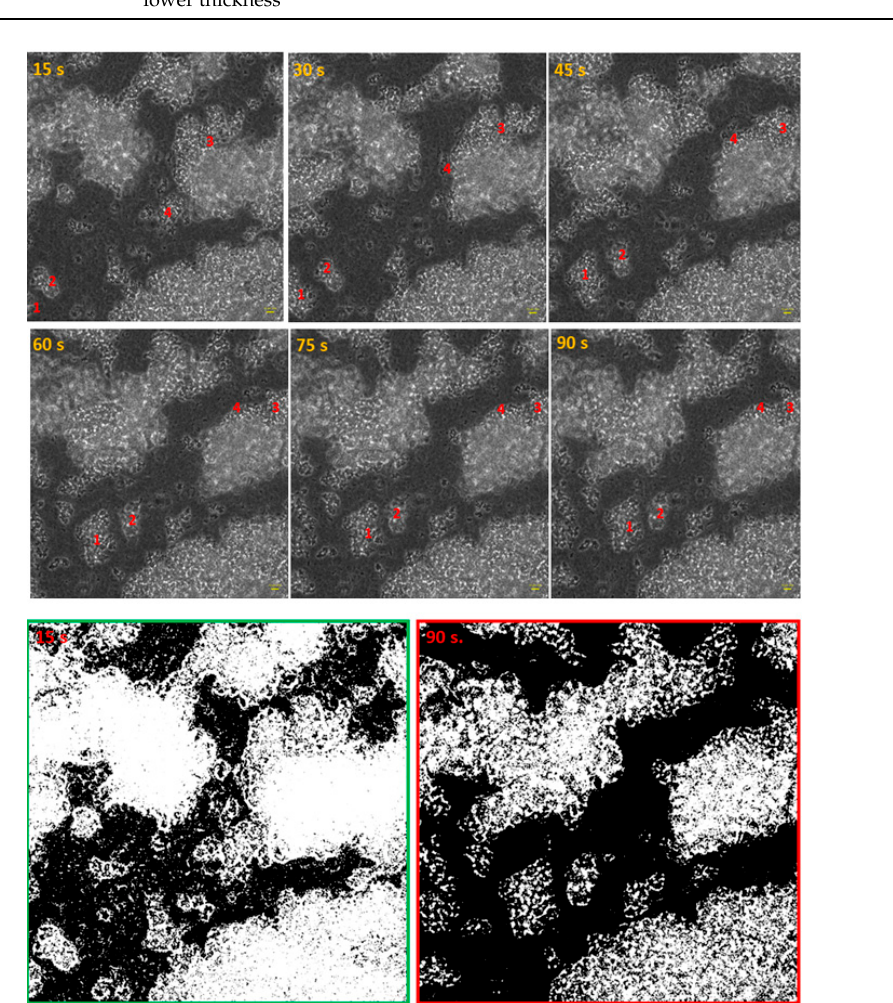
Figure 6. The impact of medium removal on the distribution of staphylococcal (ATCC33591) biofilm within 90 s of observation. Numbers 1–4 designate exemplary staphylococcal cell aggregates